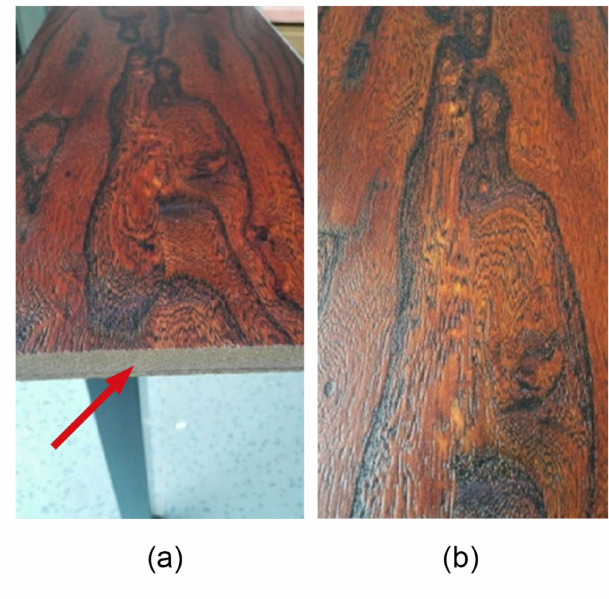
Figure 8. ( a ) medium-density fiberboard (MDF) printing substrate and ( b ) 3D elm texture on